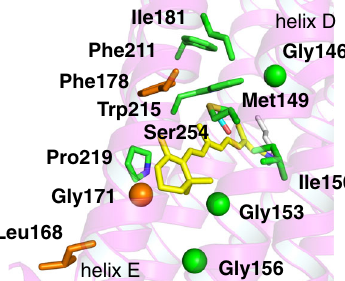
Fig. 1 Non-polar amino acid residues around the retinylidene β -ionone ring in KR2. The residues mutated to the identical ones as occurring in Chrimson and nine further screened residues are coloured in orange and green, respectively. The C α atoms are shown as spheres for Gly residues. Ser254 near the retinylidene moiety (in yellow) is coloured in cyan